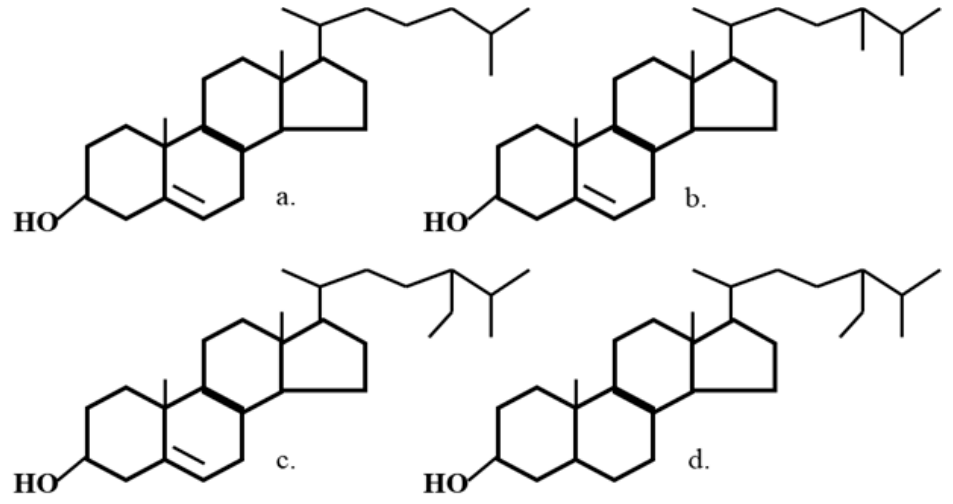
Figure 1. Chemical structures of ( a ) cholesterol, ( b ) campesterol, ( c ) β -sitosterol, and ( d ) β -sitostanol.